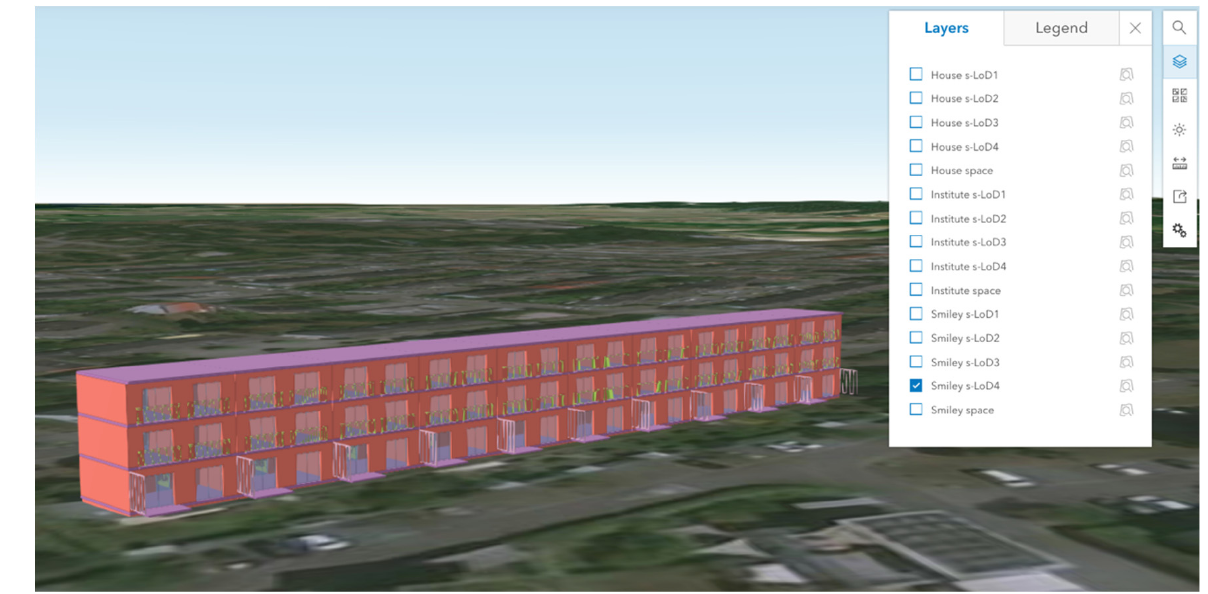
Figure 14. Smiley building of s-LoD4 on ArcGIS Online.